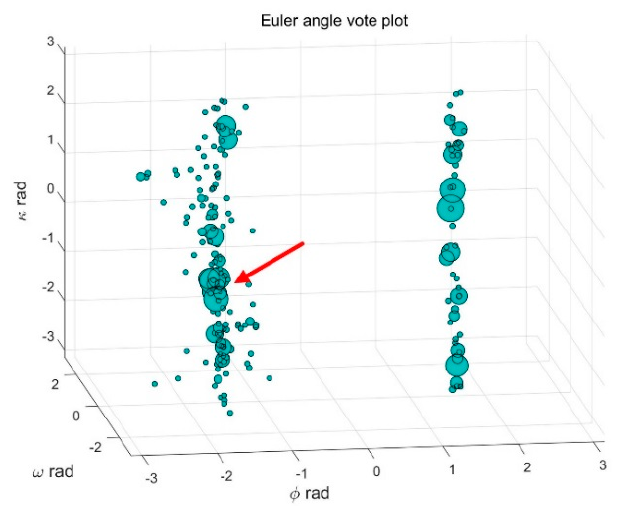
Figure 7. Euler angle vote plot.